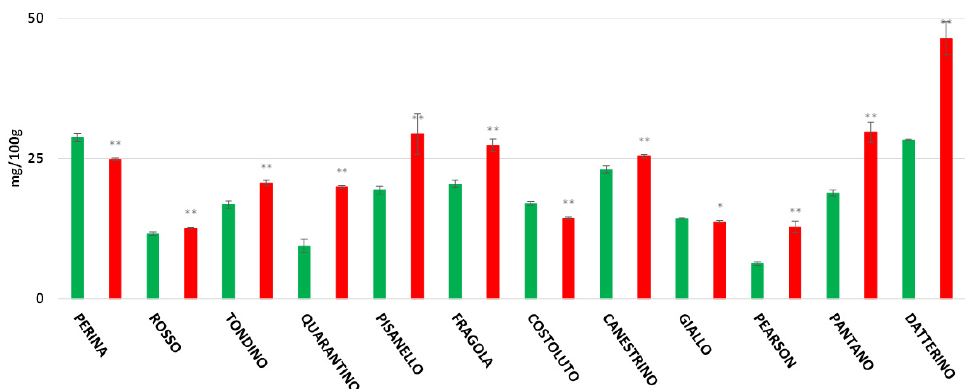
Figure 13. Rutin content in tomato peel of 9 Italian cultivars and three commercial cultivars. Controls (CTRL) in green and drought-stressed group (DS) in red. The bars indicate the standard deviation. A significant difference is shown between CTRL and DS of each cultivar by * for a p ≤ 0.05 and ** for p ≤ 0.01.